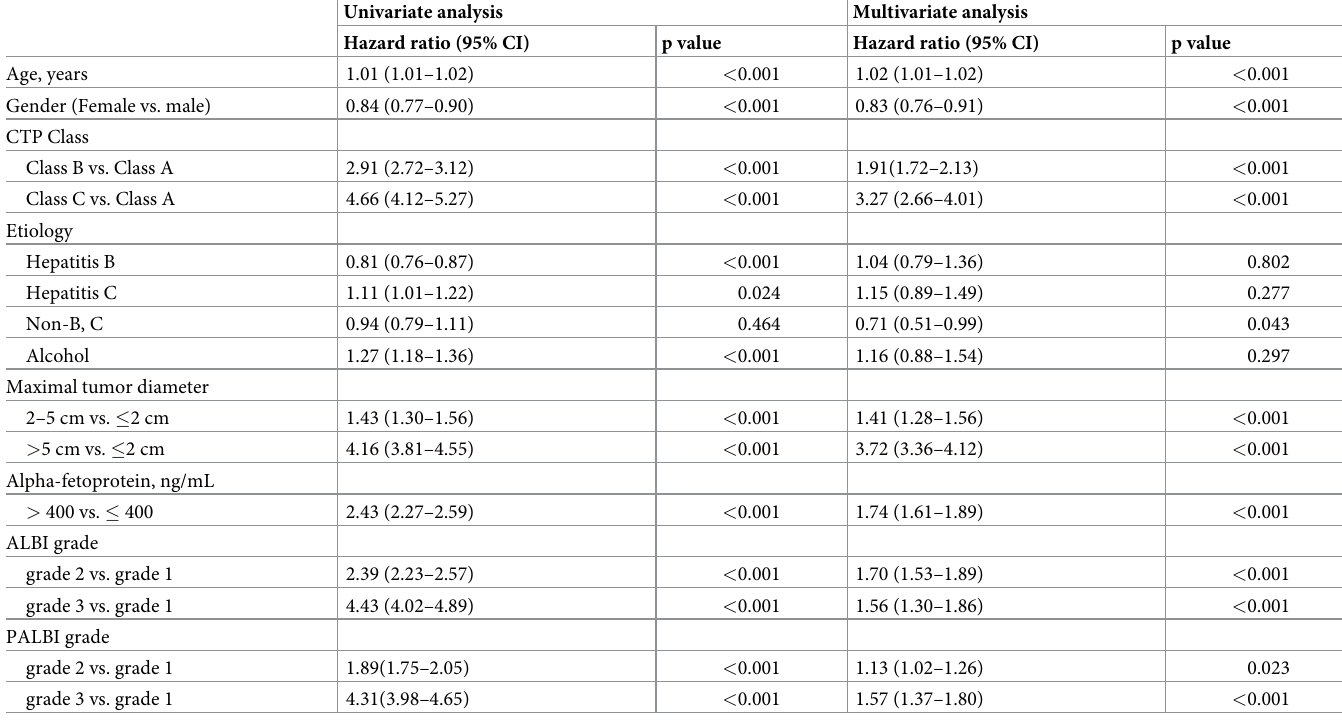
Table 4. Cox regression analysis including ALBI and PALBI grade on overall